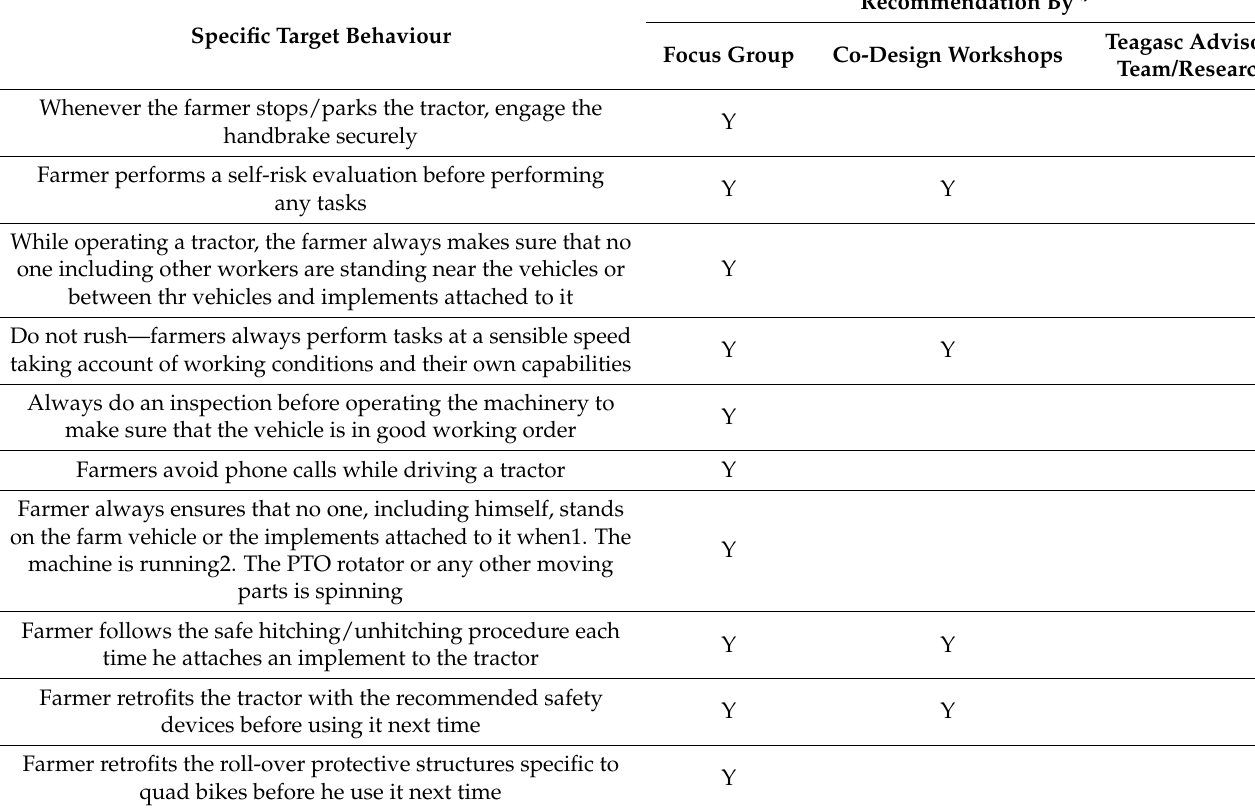
Table 2. Summary of potential target